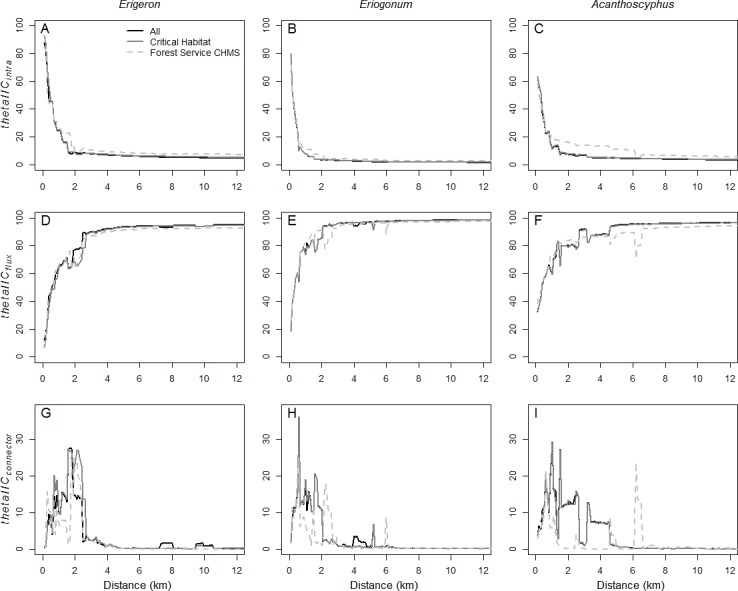
Relative contributions of intrapatch area, flux, and connector fractions of connectivity.Comparison of the relative (theta) contribution of sum_varIICintra (A–C), sum_varIICflux (D–F), and sum_varIICconnector (G–I) to sum_varIIC for the full network, critical habitat, and the Forest Service’s carbonate habitat management strategy for Erigeron parishii (A, D, G), Eriogonum ovalifolium var. vineum, (B, E, H) and Acanthoscyphus parishii var. goodmaniana (C, F, I). Note the y-axis scale difference for thetaIICconnector.